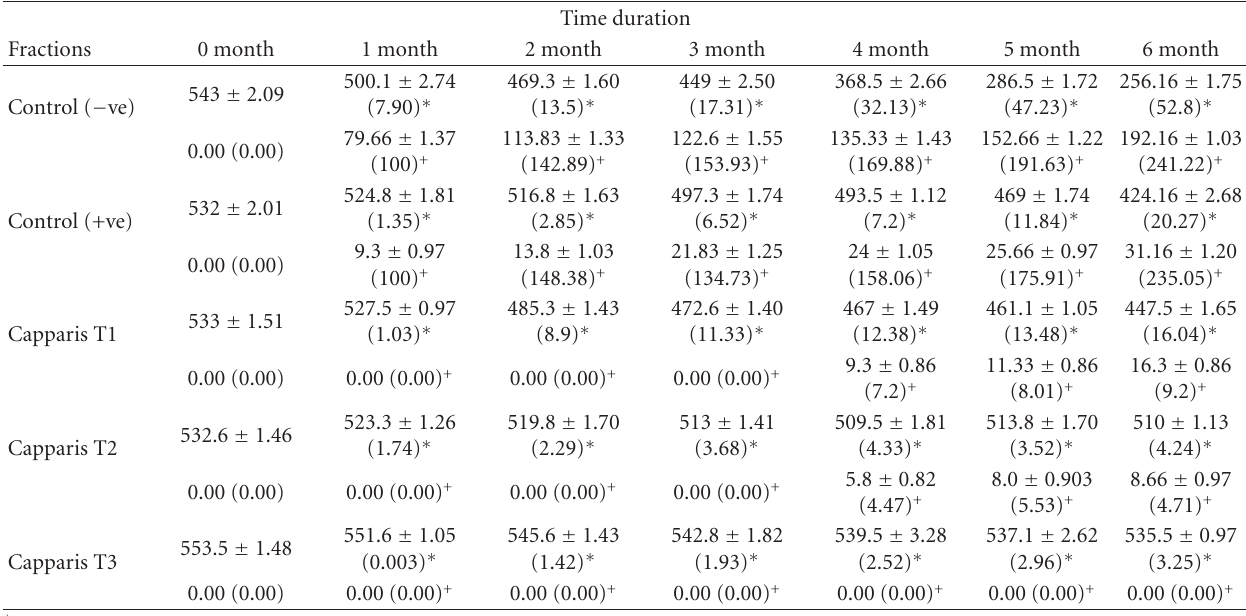
Table 4: E ff ect of C. decidua stem extract on weight loss and infestation in seasoned wood sticks planted in garden